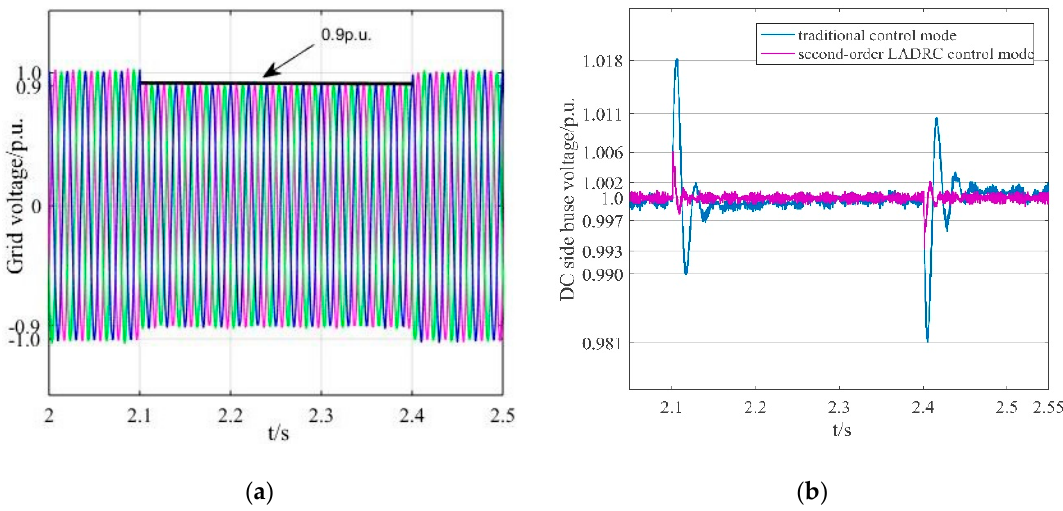
Figure 11. DC side bus voltage waveform under two control modes when the grid voltage is symmetrically dropped by 10%. ( a ) grid voltage waveform; ( b ) DC side bus